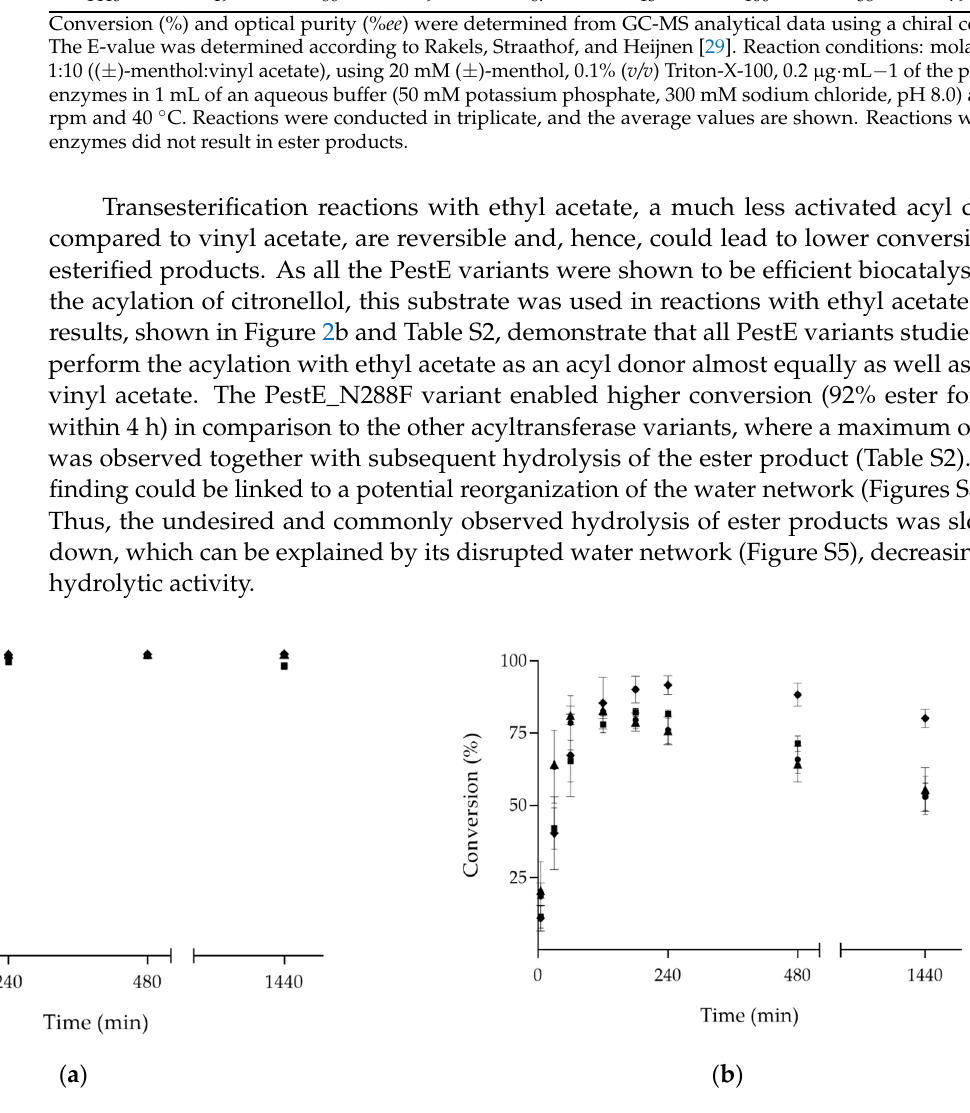
Table 1. Menthyl acetate conversion and product enantiomeric excess from transesterification reactions catalyzed by PestE wild type and mutants.